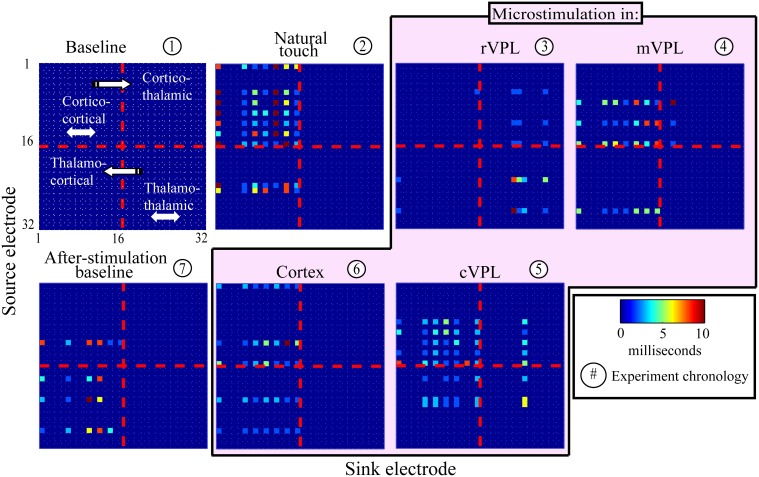
An example of model temporal order-coded, statistically significant pair-wise causal interactions. Data are from one recording session (mean of 180 trials; see Materials and Methods, Section Subjects, Surgeries, and Experimental Procedures). Electrode numbers 1–16 are located in primary somatosensory cortex, and numbers 17–32 are located in VPL thalamus in the anesthetized rat. Panel titles describe recording condition. Color bar shows model order (i.e., time offset in ms) that showed maximally significant causal links. Directions of causal influences are represented by the convention illustrated in panel 1. Channel pairs rarely had significant causalities at multiple model orders, but if they did, only the highest statistically significant (lowest p-value) one is displayed.